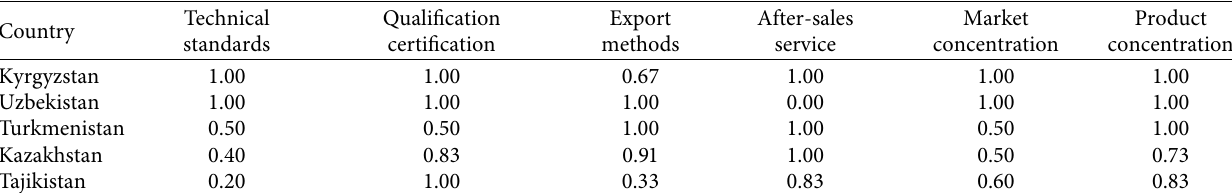
Figure 8: Matching effect picture of Chinese power companies in Central Asia. Table 6: Matching indicators value of Chinese power companies in Central Asia.